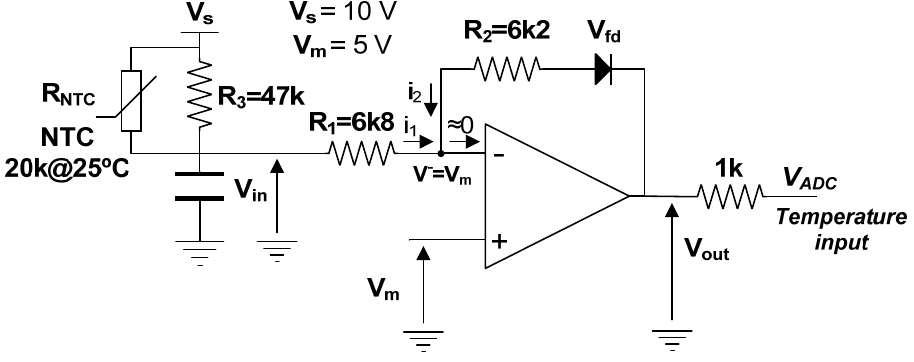
Figure 8. Signal conditioning circuit for the embedded temperature sensor (NTC).